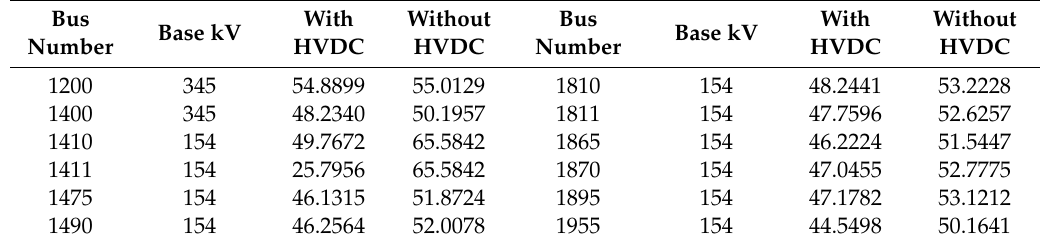
Table 4. Fault current comparison with / without HVDC [kA].